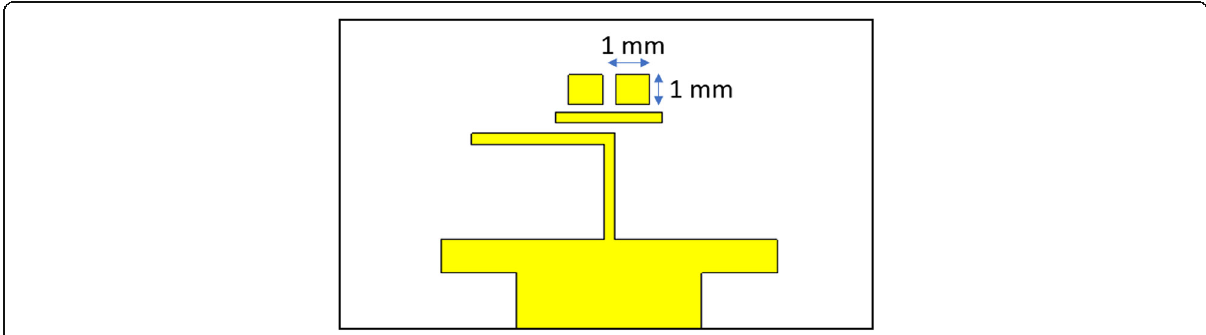
Fig. 10 Rectangle-shaped parasitic and the two square parasitics coupling onto the dipole